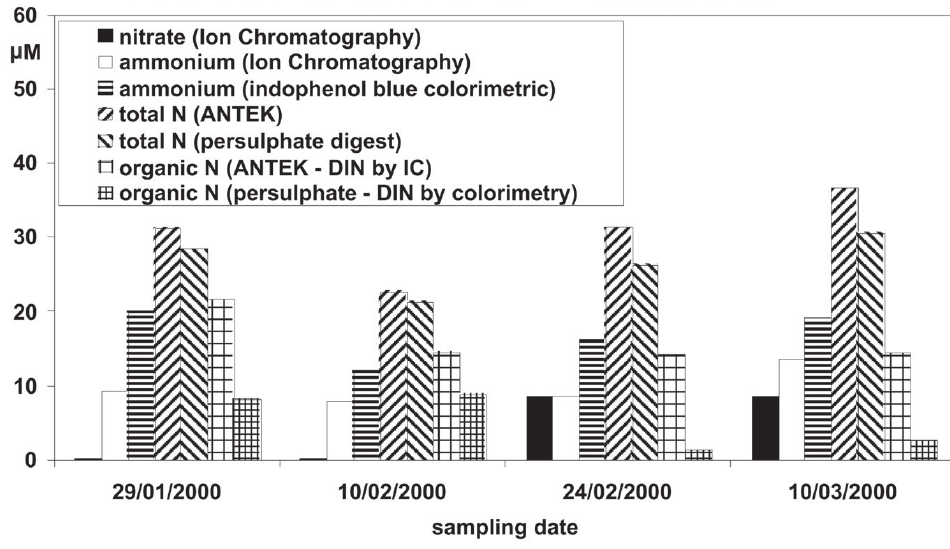
FIGURE 1. Comparison of analytical methods (Bush Estate, January-March 2000). Samples without thymol.